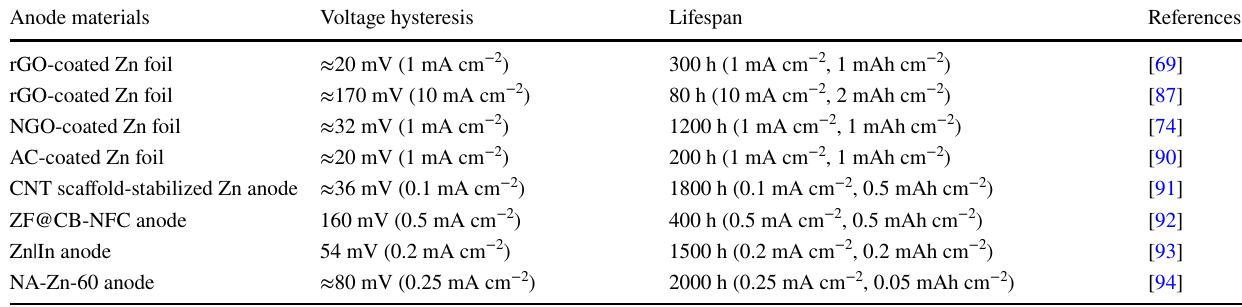
Table 1 Summary of recently reported coatings modification strategies for carbon-based and metal-based materials Anode